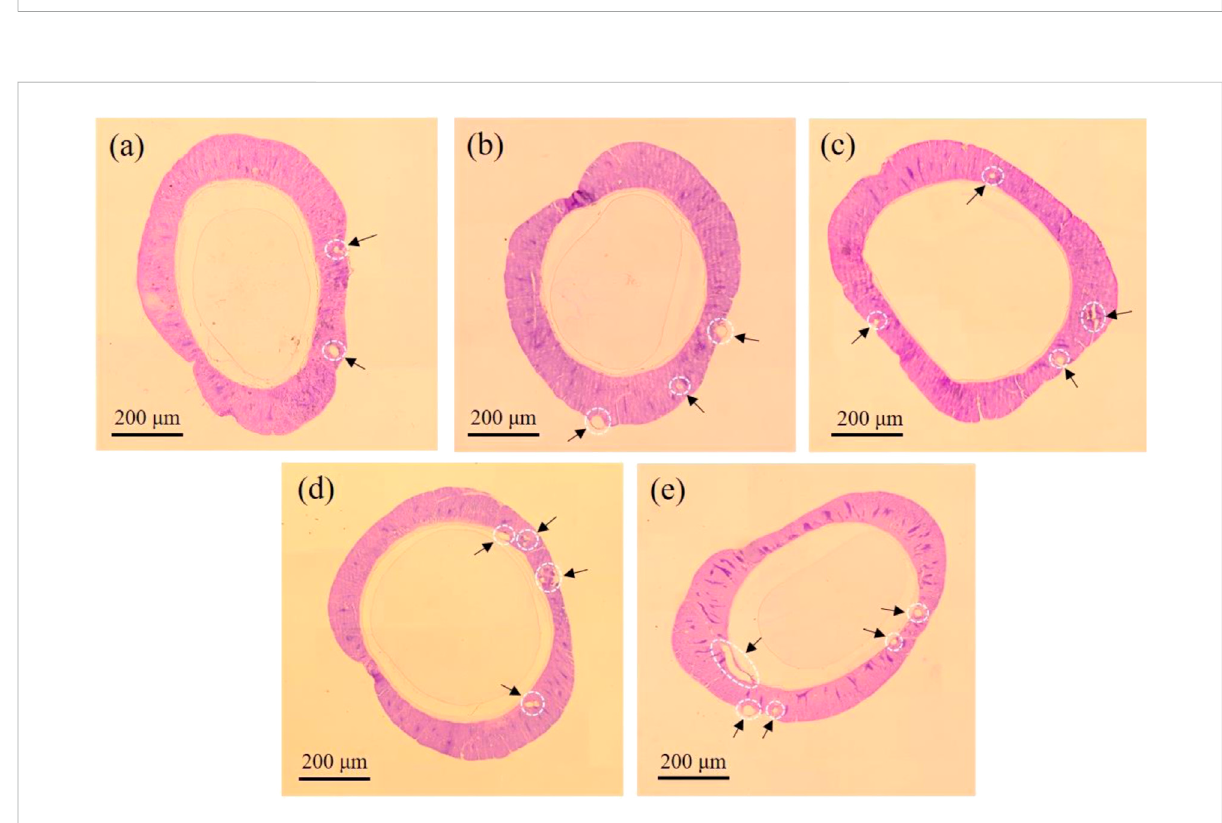
understand the impact of AMT on PSG development. Silkworm silk-gland tissue includes the outer epithelial membrane, gland cells, and inner epithelial membrane (Akai, 1983). Among these, gland cells are involved in the secretion of silk proteins. The number of gland cells is positively correlated with the silk production quantity (Wu et al., 1961). Therefore, the sparseness of silk gland cells re fl ects the degree of silk gland injury (Cheng et al., 2018). As shown in Figure 4, the gland cell population decreased with increasing AMT feeding dosage, and